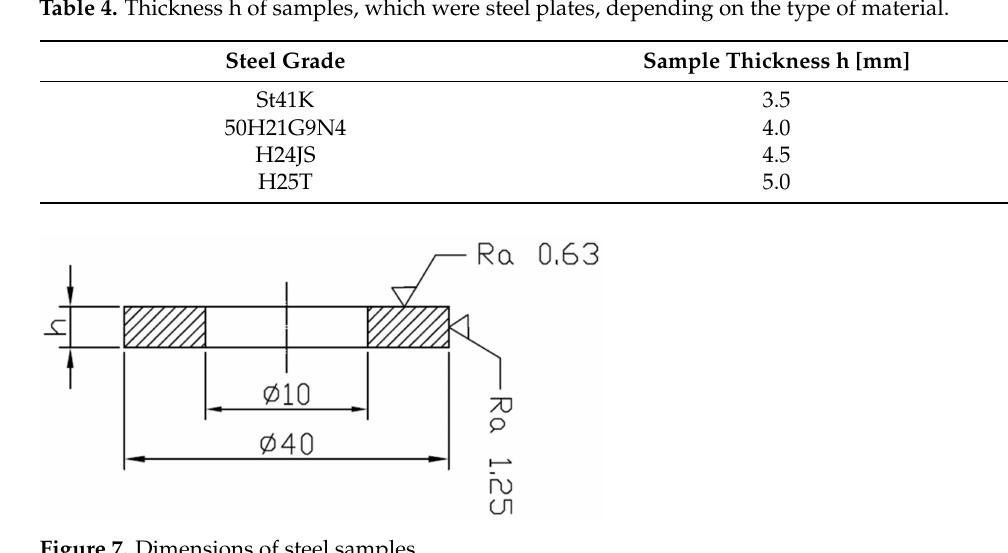
Figure 7. Dimensions of steel